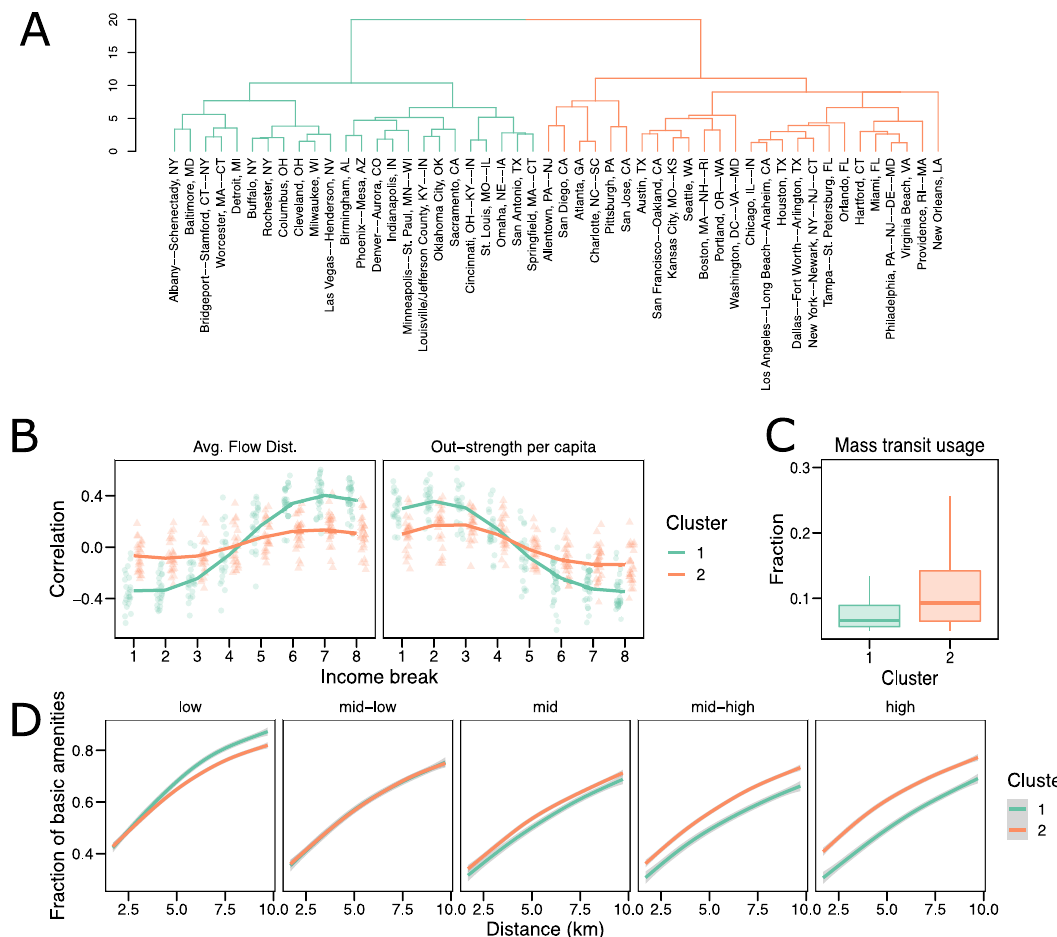
Figure 4. Clustering analyses of cities in United States. ( A ) Dendogram obtained from a divisive hierarchical clustering method to partition cities into two different groups color-coded in teal and orange. ( B ) Spearman correlation between eight income breaks ( ID f ), and the average flow distance and out-strength per capita. ( C ) Fraction of the population using mass transit for each of the clusters. ( D ) Fraction of basic amenities accessible as a function of distance for 5 income breaks ( ID q ) for each of the